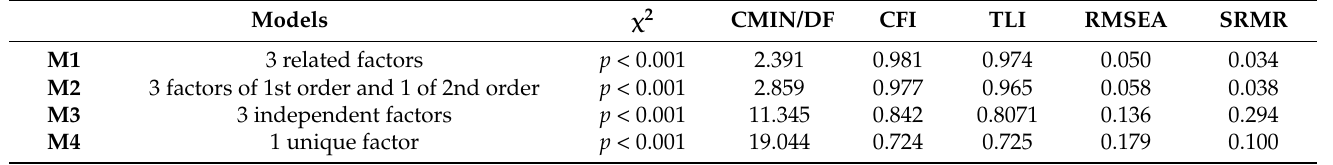
Table 4. Goodness-of-fit indices of the proposed academic failure attribution